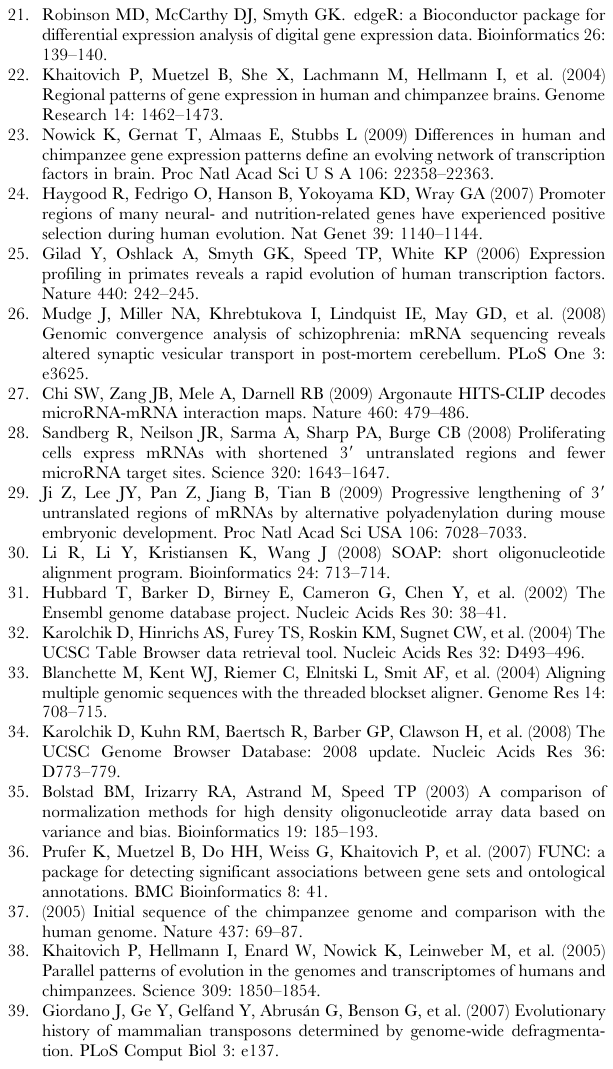
Table S8 Species-specific HTR Table S9 Annotation of genomic DNA expressed in HTR Table S10 Species-specific GW Table S11 Annotation of genomic DNA expressed in